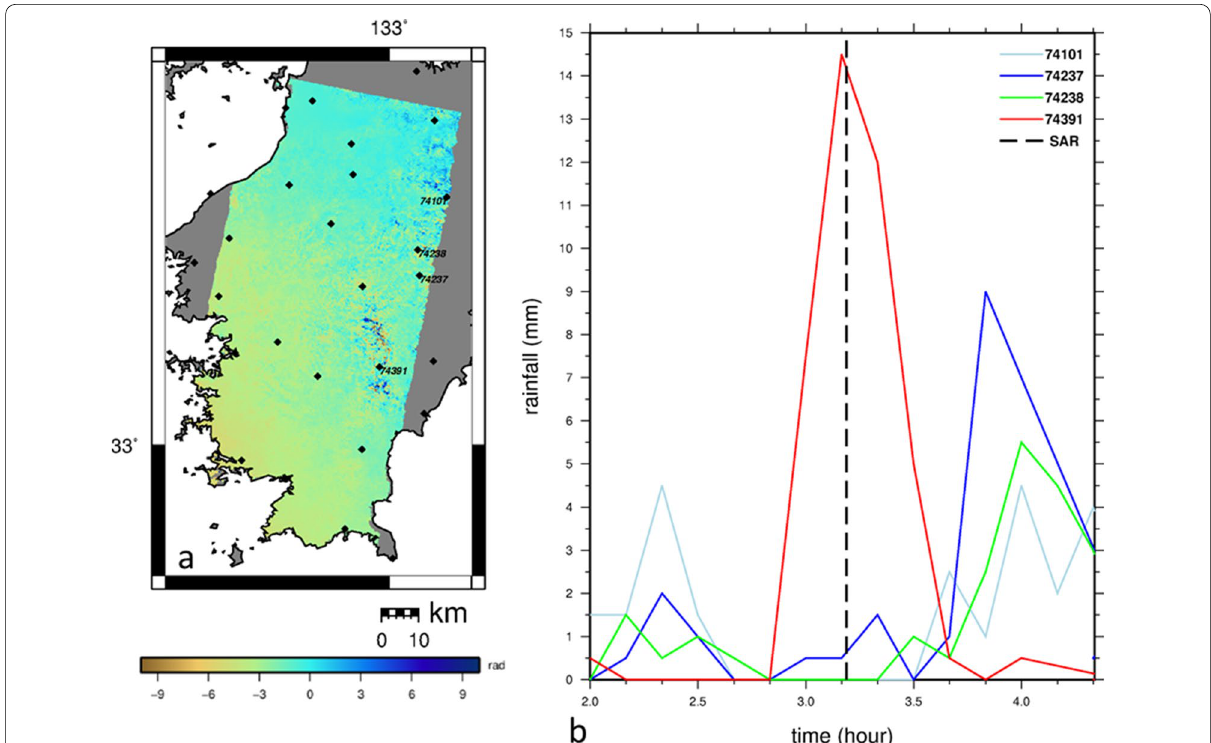
Fig. 7 �φ dispersive of SSM on Shikoku 20180815_20181107. a Overlaid by the AMeDAS station distribution and ( b ) the temporal changes in the 10 min rainfall and the SAR imaging time indicated with the black dashed